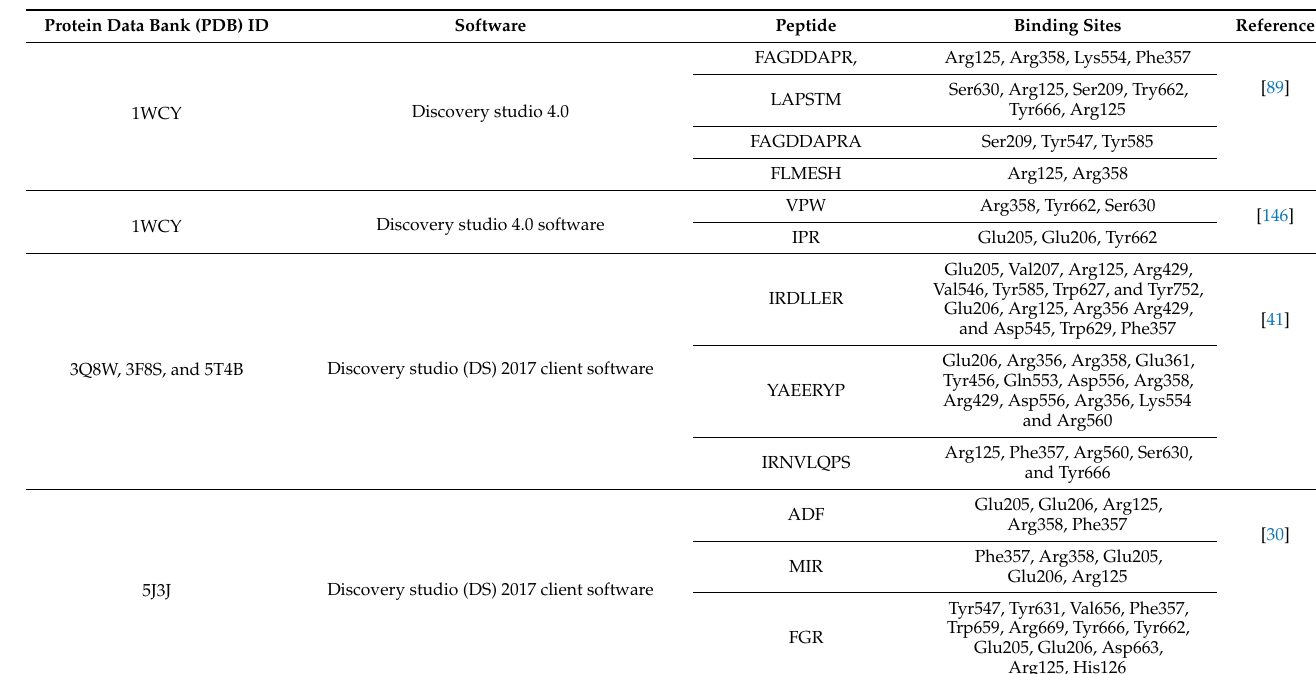
Table A3. Summary of the interaction of peptide—DPP_IV proteins using the molecular docking